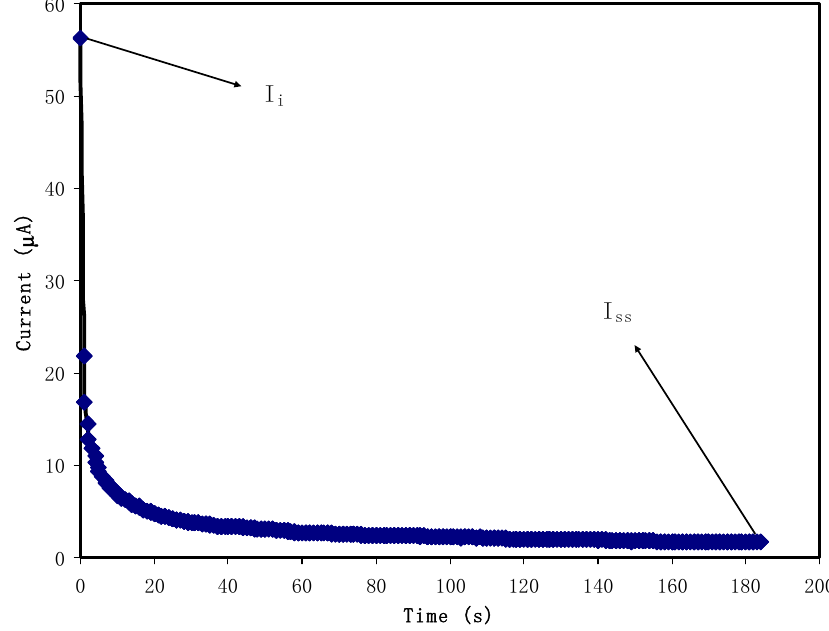
Figure 6. Polarization of SS | best conducting electrolyte | SS at 0.80 V.